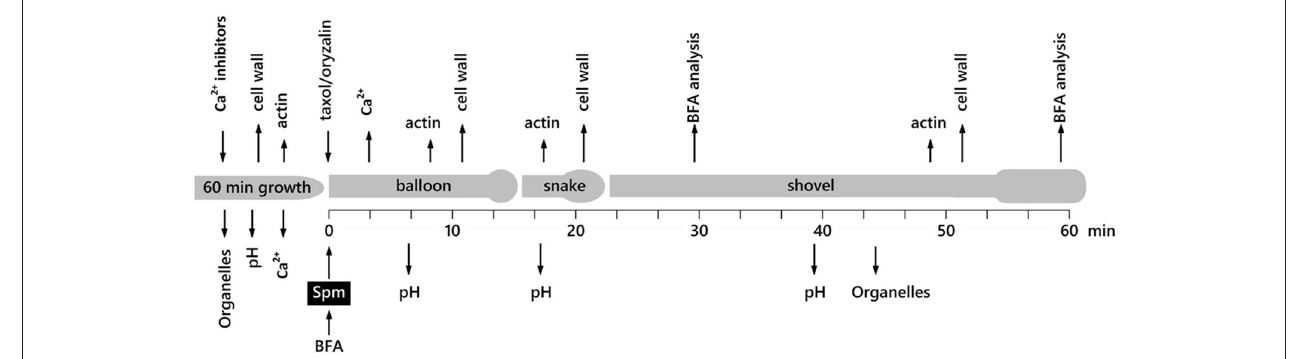
FIGURE 1 | Time scale of the various morphological stages of pear pollen tubes after treatment with Spm and of the main analyses performed.